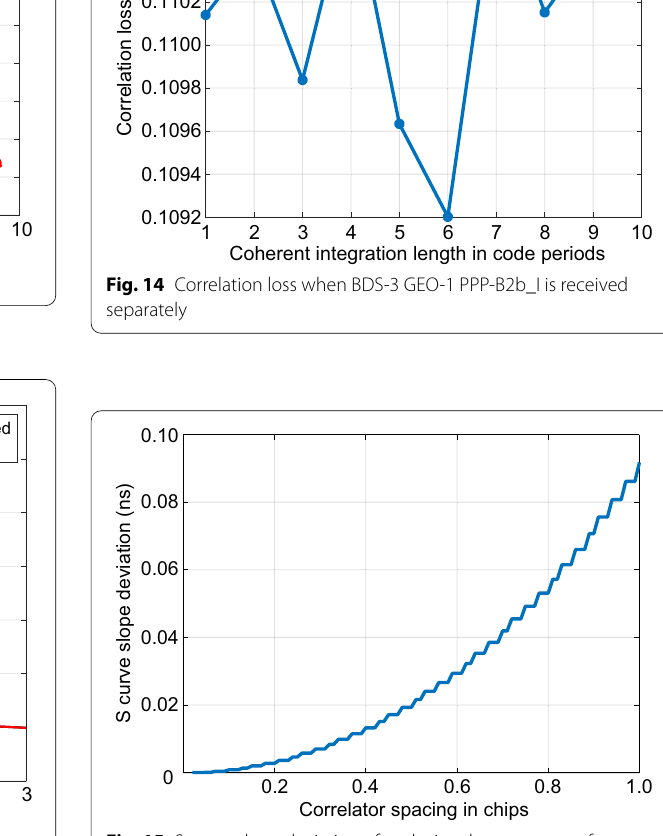
Fig. 13 Correlation function when BDS-3 GEO-1 PPP-B2b_I is